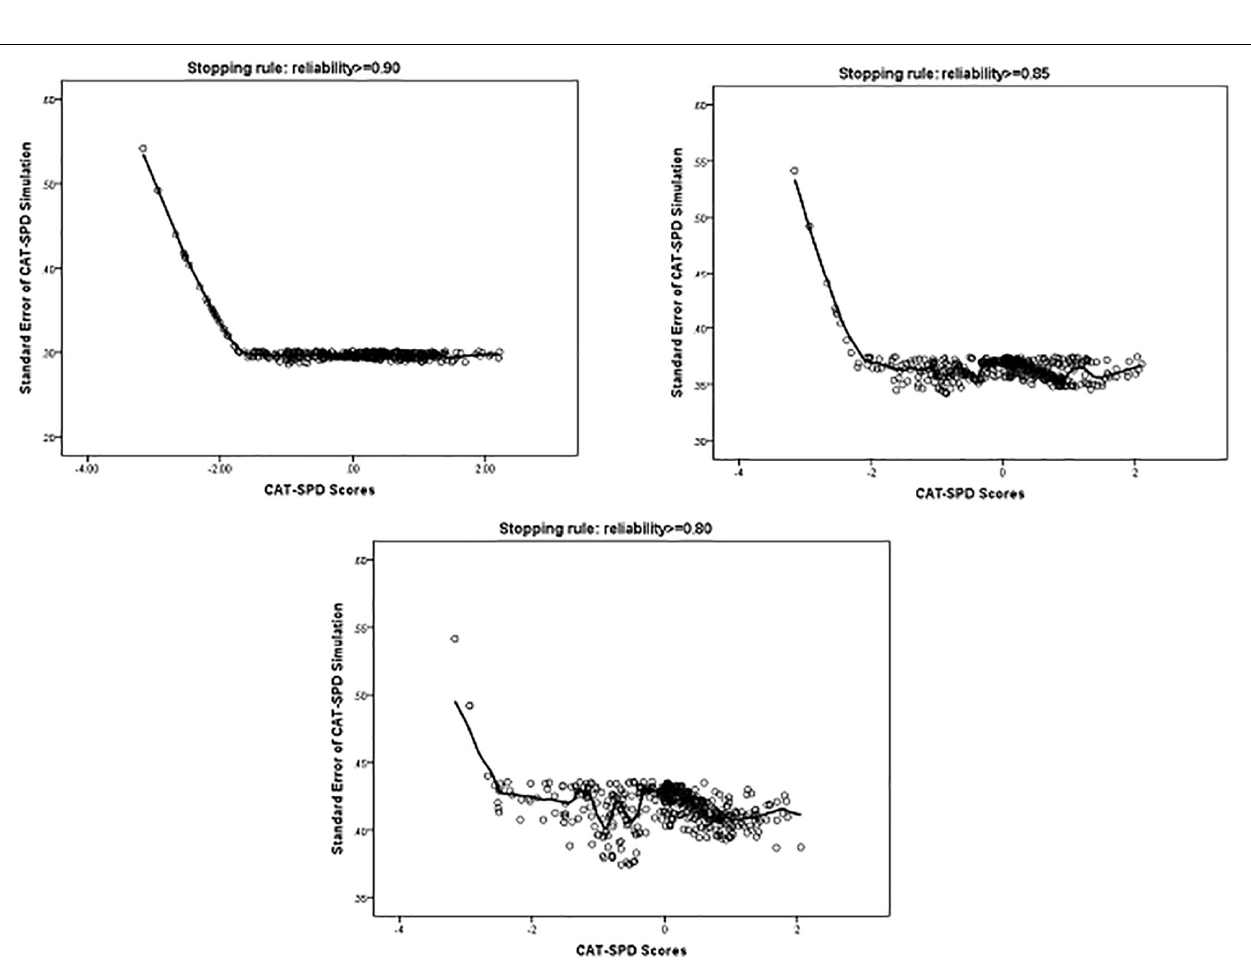
FIGURE 3 | Standard Error (SE) of CAT-SPD score under different stopping